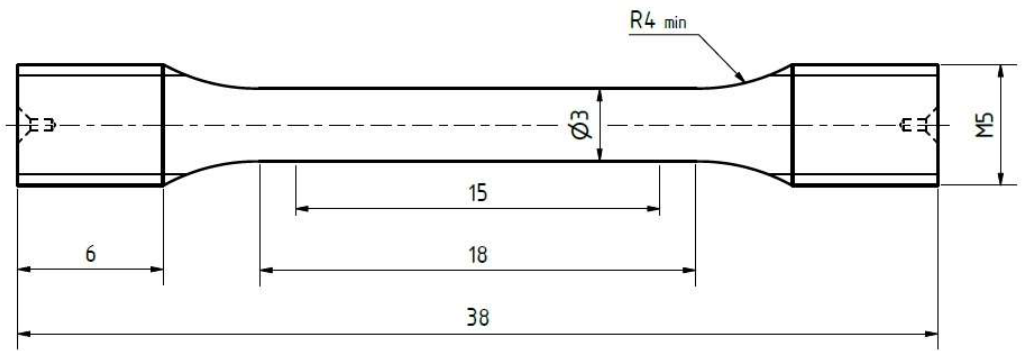
Figure 7. Geometry of the tensile specimens. All dimensions are given in millimeters.